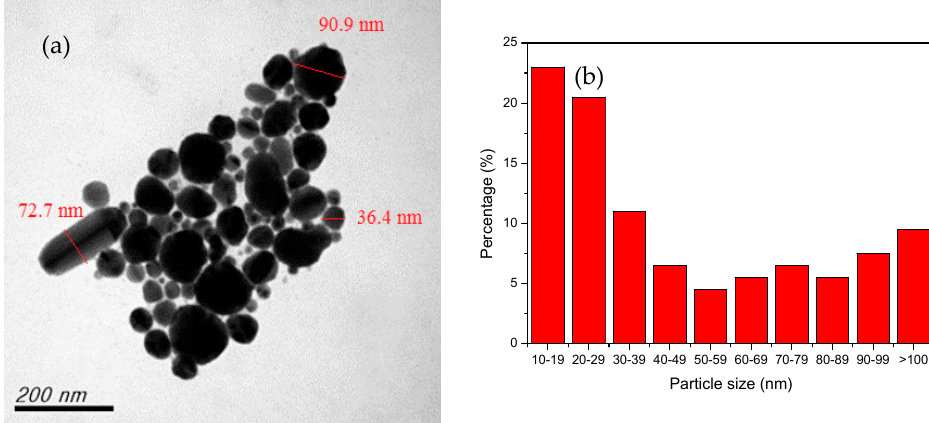
Figure 2. Primary reduction when (AA)/(CuSO 4 ) = 15 and pH = 10.5. ( a ) TEM. ( b ) Particle size distribution.